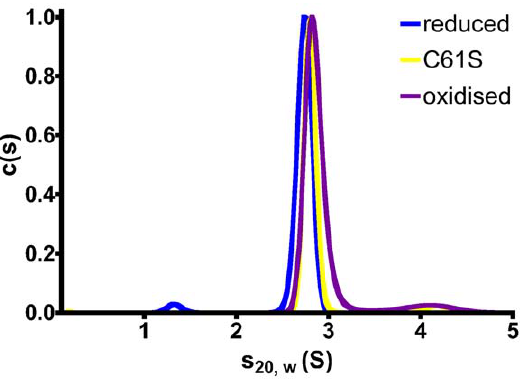
Figure 5. Analytical ultracentrifugation. c(s) distributions derived via SEDFIT from SV data for yp Tpx in oxidised (purple) and reduced (blue) states, as well as yp TpxC61S (yellow) indicate that the protein is monodisperse (dominated by a single, symmetrical peak) with the same sedimentation coefficient regardless of redox state.